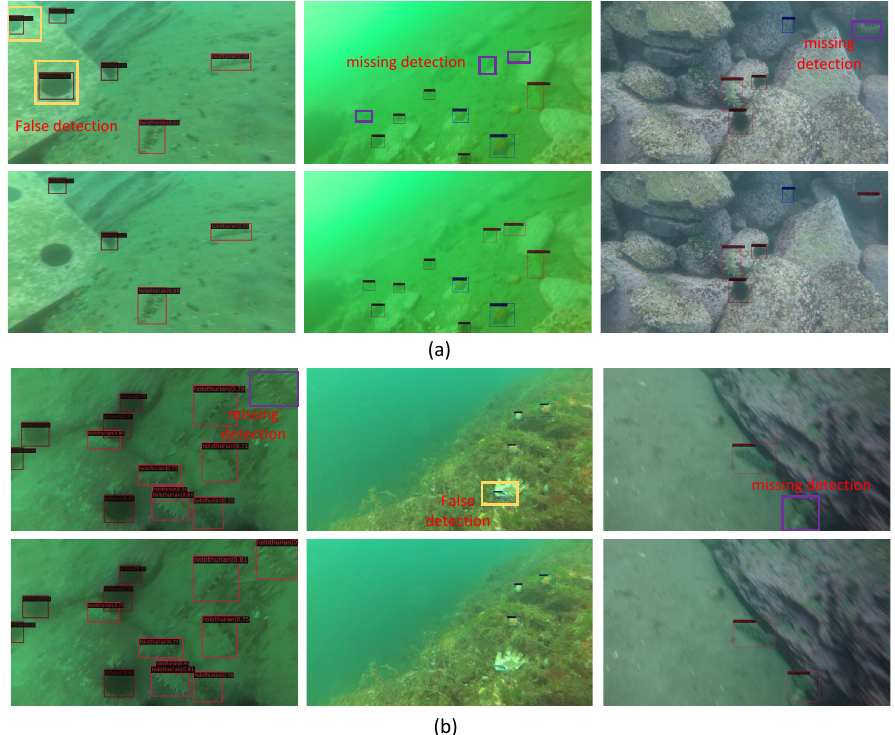
Figure 10. The detection results of the proposed method. ( a ) shows the results on the DUO dataset. ( b ) shows the result on the URPC2021